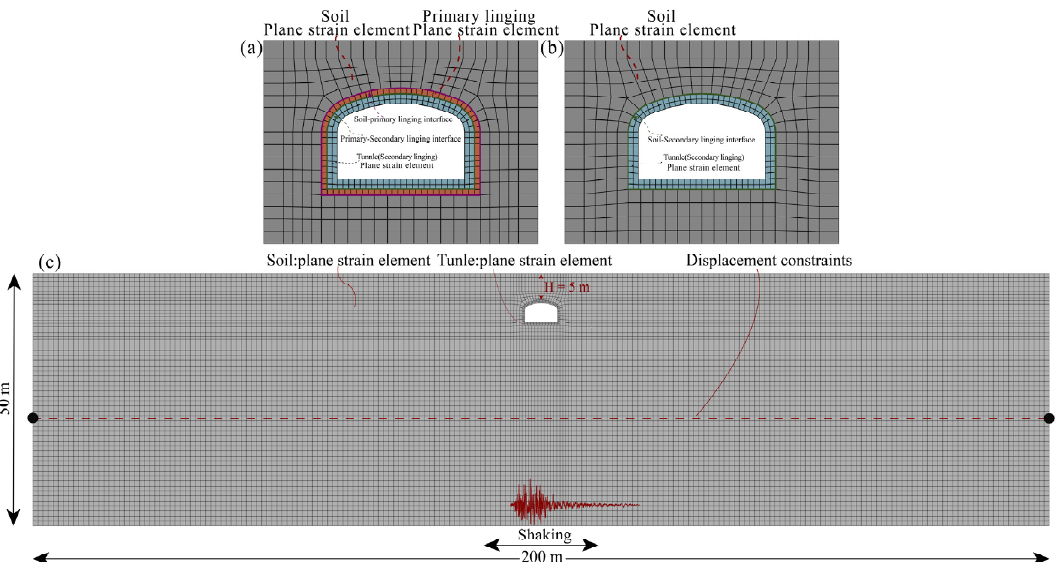
Figure 2. 2D Finite element model ( a ) tunnel with primary lining ( b ) tunnel without primary lining ( c ) soil-tunnel model layout. Table 3. Numerical cases for dynamic response.